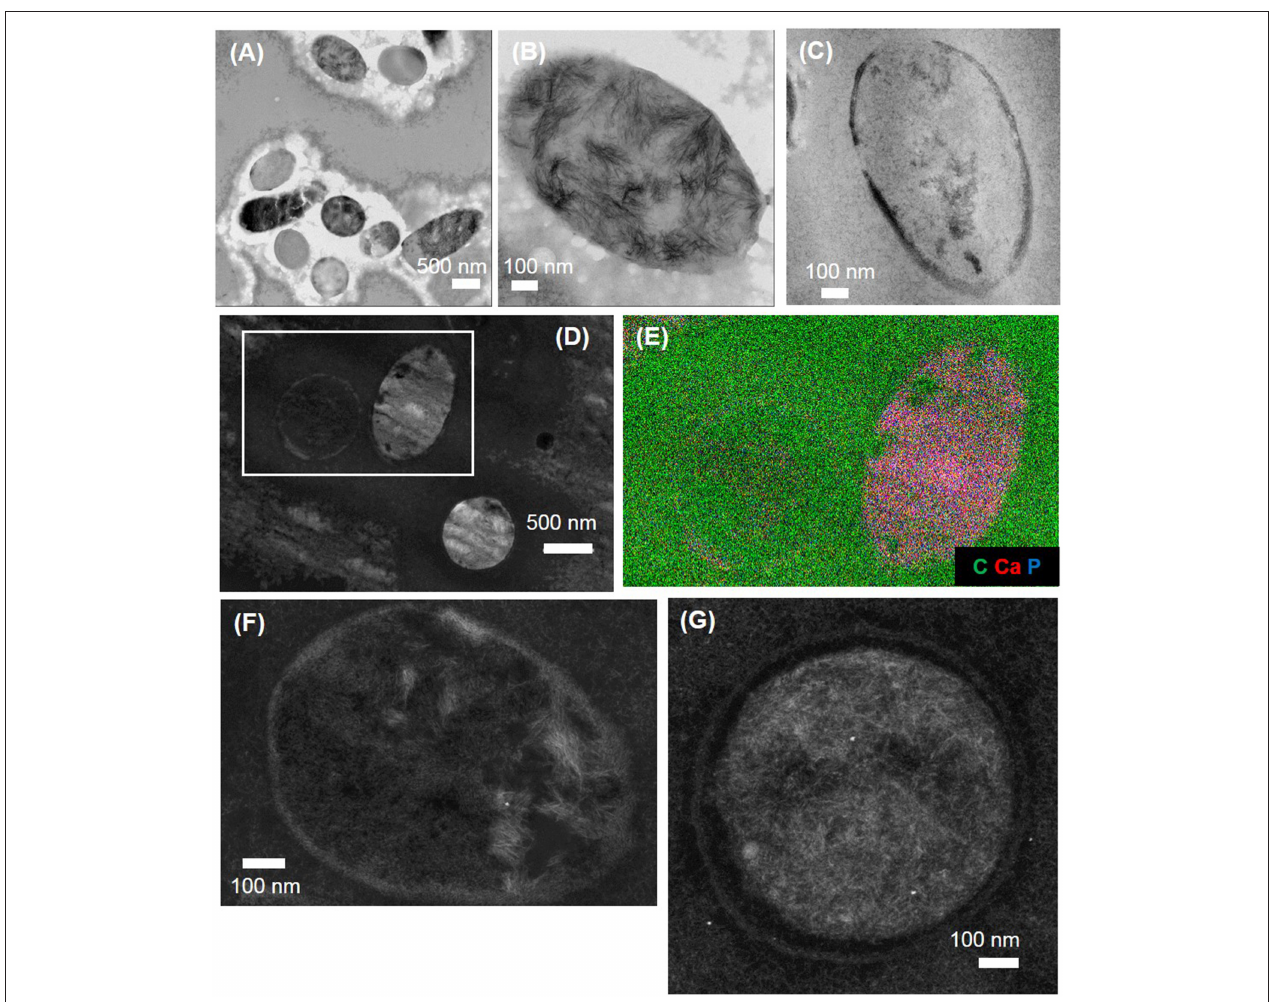
FIGURE 4 | TEM (A–C) and STEM (D,F,G) images of APm1 after 1 week in the calcification medium. (A) Cluster of encrusted cells. The Ca-phosphates located directly in contact with the cells have been partially removed by ultramicrotomy, leaving holes around the bacteria. (B) Cell having intracellular Ca-phosphate precipitate presenting a fibrous texture, with fibers radiating from the periphery of the cell. (C,F,G) Cells surrounded by an electron-dense crown, with a mean thickness of ∼ 24.4 ( ± 5.3) nm, likely resulting from the precipitation of Ca-phosphates within the periplasm of the cells. (E) EDXS map of C (in green), Ca (in red), and P (in blue) obtained on the area depicted by a rectangle in (D) .